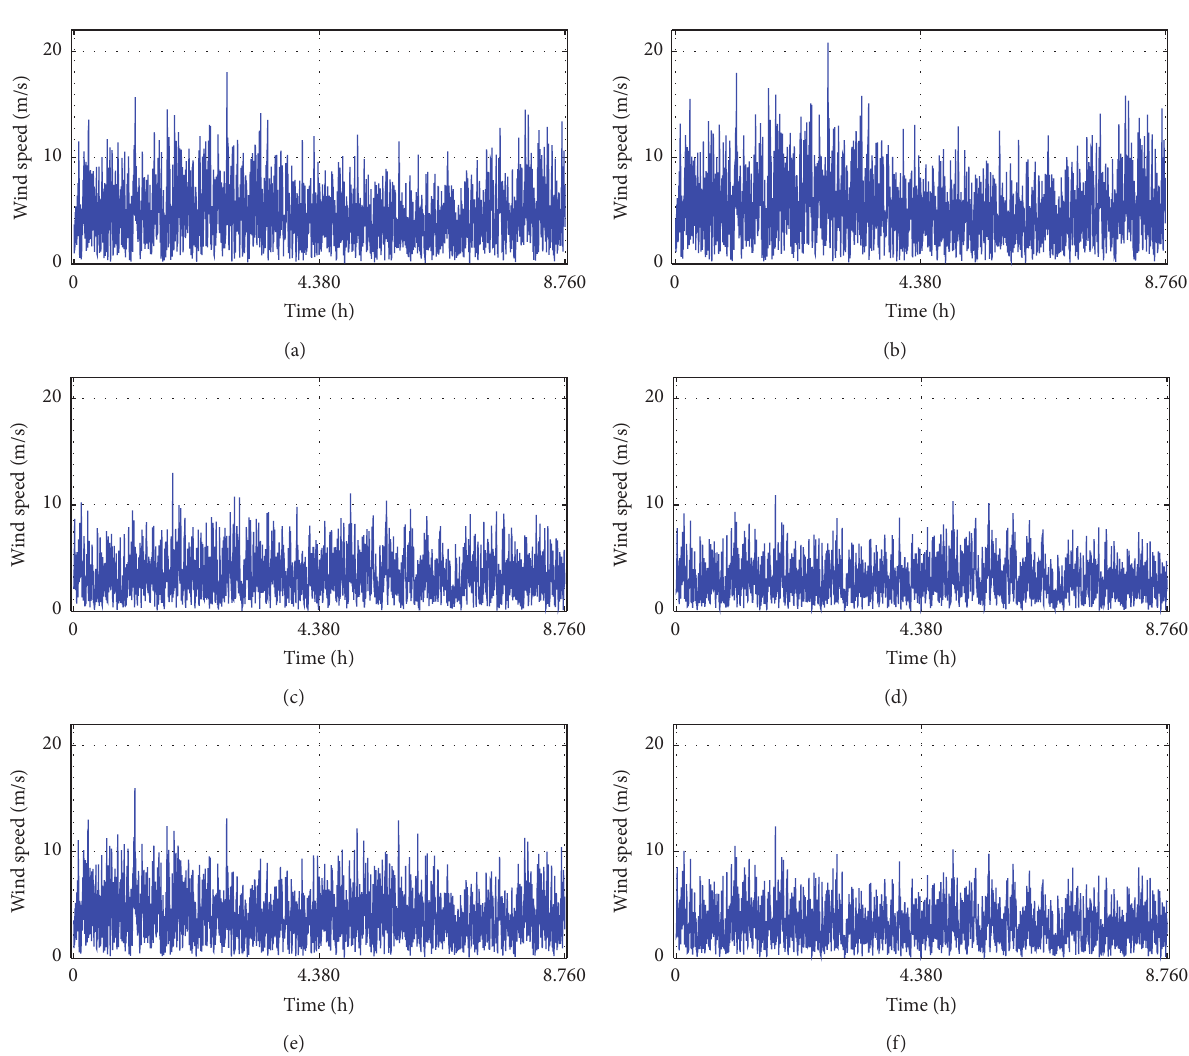
Figure 5: Computed hourly wind speed data using 10-year monthly average daily wind speed data [16] for (a) Katsina, (b) Yola, (c) Abuja, (d) Nsukka, (e) Lagos, and (f) Benin City,